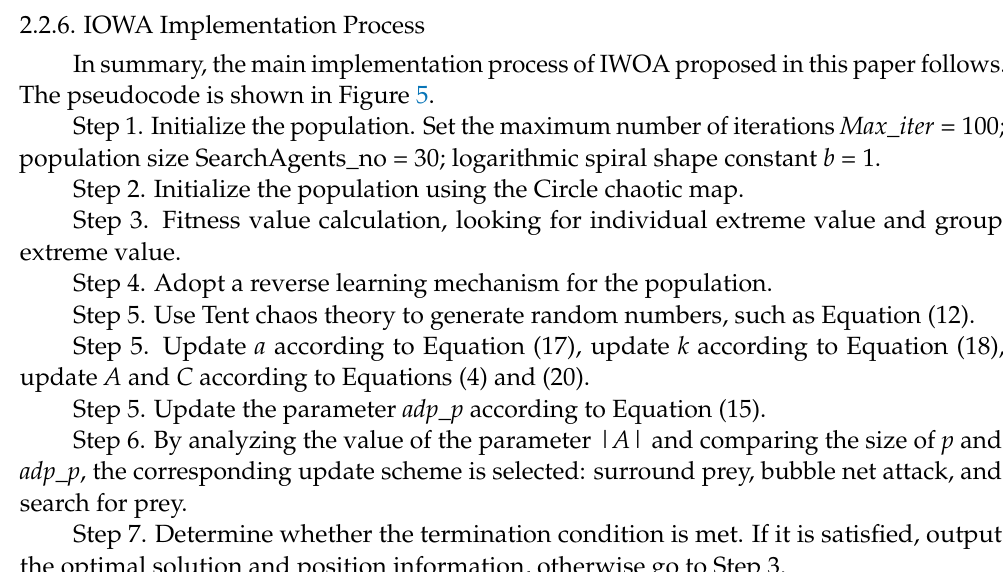
Figure 4. Effect of the number of iterations on k .